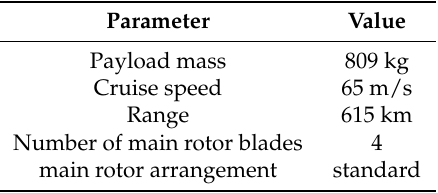
Table 3. Minimum TLARs identified for the ACT/FHS research helicopter.